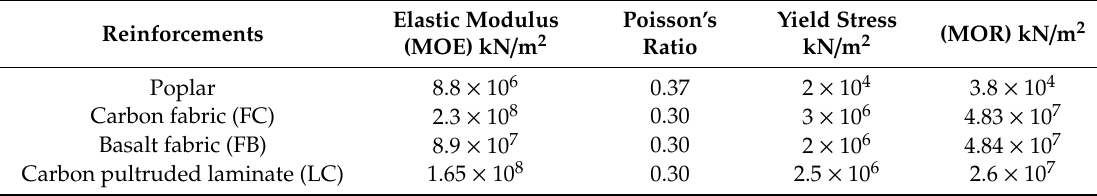
Table 3. FRP properties for each particular